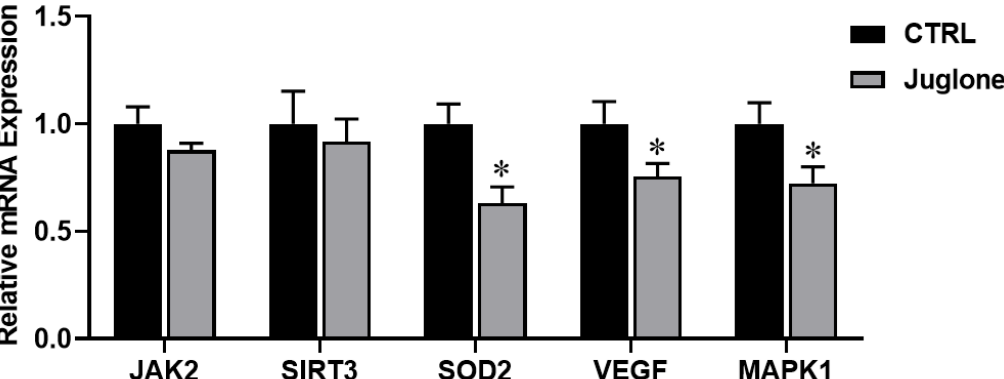
Figure 6. The relative expression of oocyte survival-related genes tested using RT-qPCR. Bovine oocytes were treated with 25 µM of juglone during in vitro maturation (IVM) and three replicate; n = 50 were used for the experiment. Columns with asterisk ( * ) indicate statistical significance.